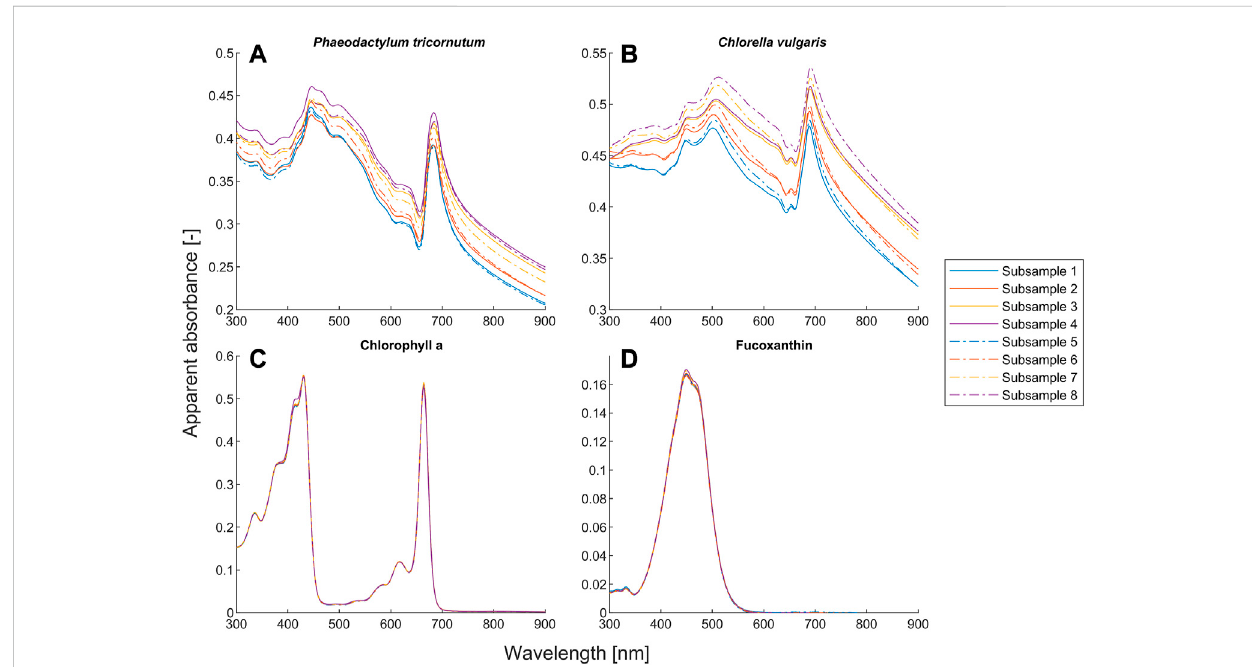
FIGURE 6 Quantitative comparison of the absorption spectra for the suspensions of Phaeodactylum tricornutum and Chlorella vulgaris and the solutions of chlorophyll a andfucoxanthin.TheabsorptionspectraofsubsamplesNo.5to8werescaledbyafactorof2forcomparisonpurpose.Thespectrawiththe same path length are given in the same color. The setups of the subsamples are given in Table